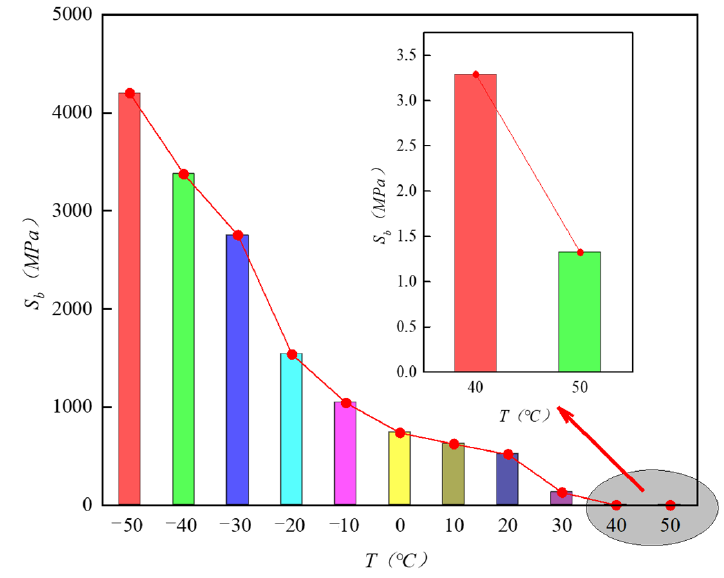
Figure 22. Failure stiffness modulus of polyurethane cement at different temperature levels.